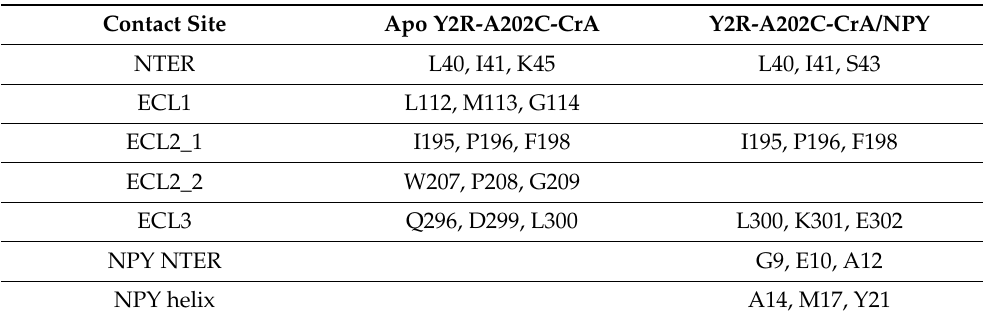
Table 2. List of amino acids in Y2R-A202C-CrA and in NPY subjected to contact at each detected contact